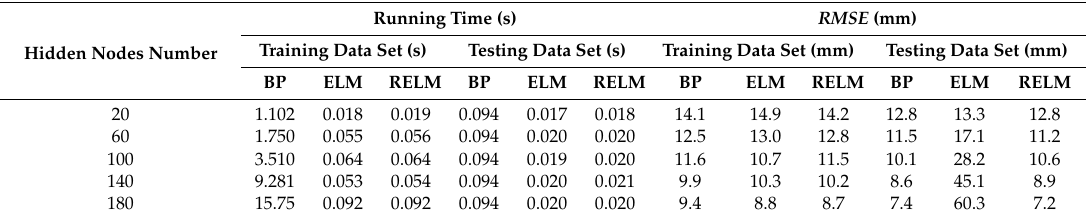
Table 5. Comparison of back propagation (BP), extreme learning machine (ELM) and regularized extreme learning machine (RELM).